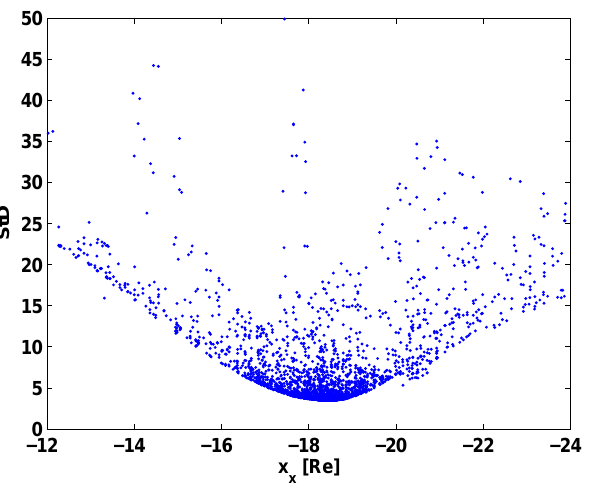
Fig. 10. Dependence of X-line location on propagation